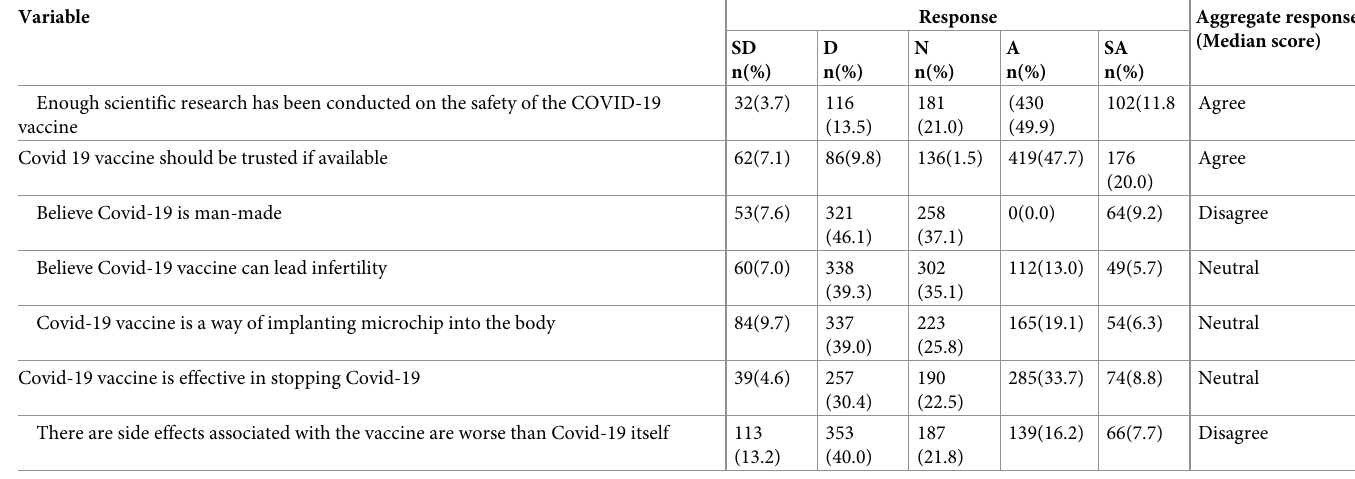
Table 2. Perception of respondents regarding the COVID-19 vaccine.